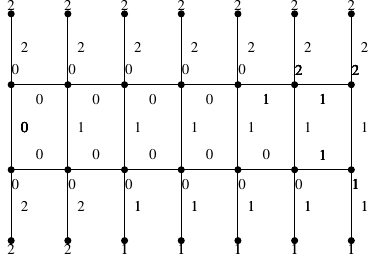
Fig. 15 3-TEPC labeling of graph L 7 (cid:12) 2 K